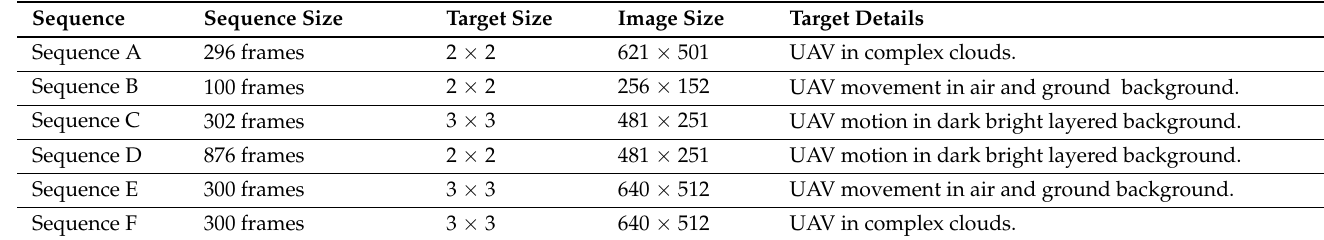
Table 3. Sequence scene-related